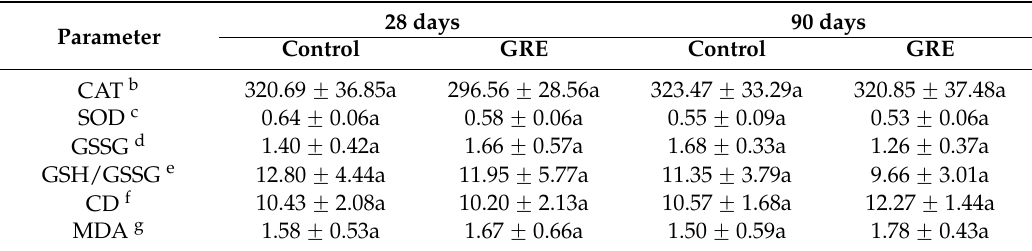
Table 4. Effect of dietary consumption of GRE a on oxidative stress liver parameters of male Fischer rats after 28 and 90 days.